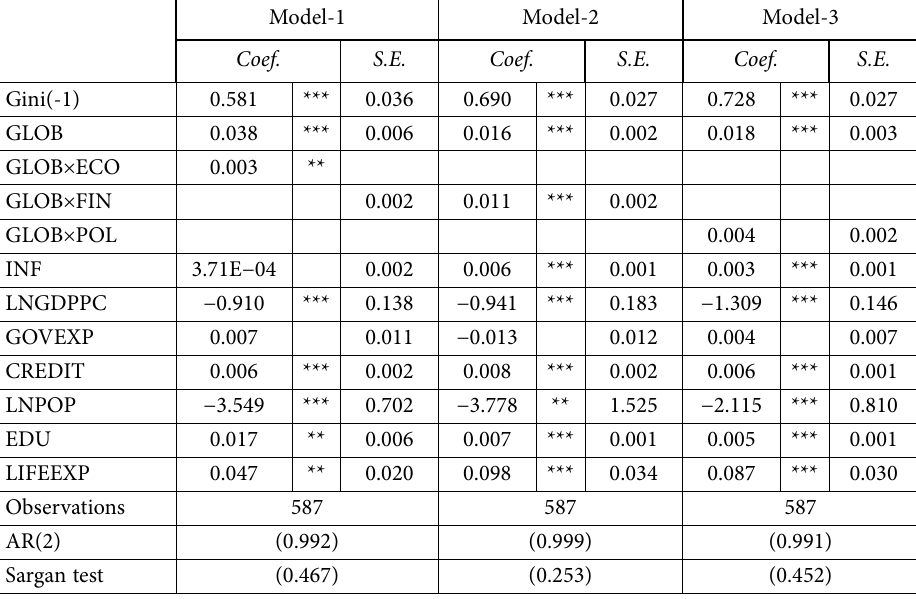
Table 11. Inequality, globalization, and country risk (OECD group) Model-1